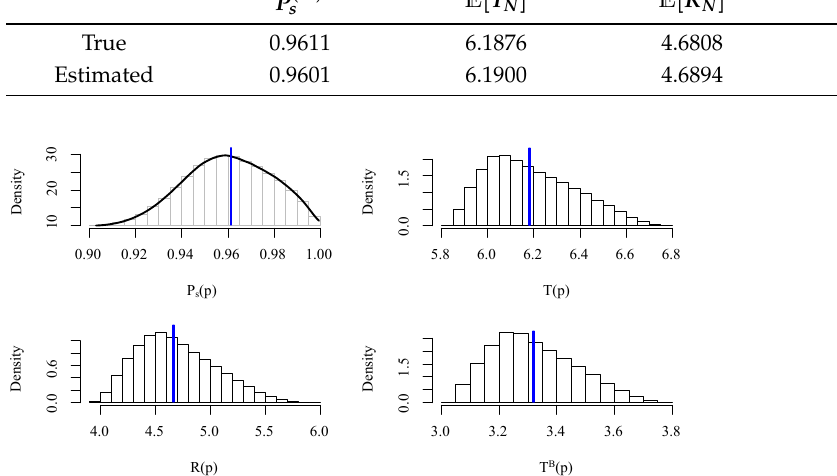
Figure 5. Estimated P ( N ) s density and histograms for P ( N ) s , T N , R N and T B probabilities. True mean values are represented by a blue vertical